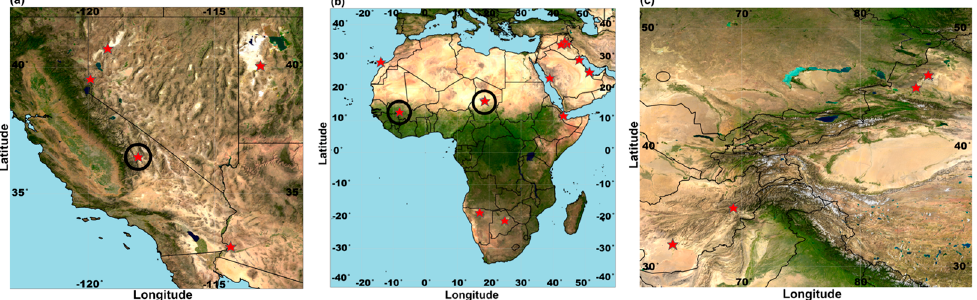
Figure 1. Stars display soil collection localities in ( a ) western USA, ( b ) Africa and Arabian Peninsula, and ( c ) central and east Asia with two representative samples used from sites marked with black circles. These samples originate from major dust source regions of the world as determined by re ‐ mote sensing and surface observations [23–25]. Appendix A, Table A1 provides more information regarding sample code, location, and collection coordinates of these samples.